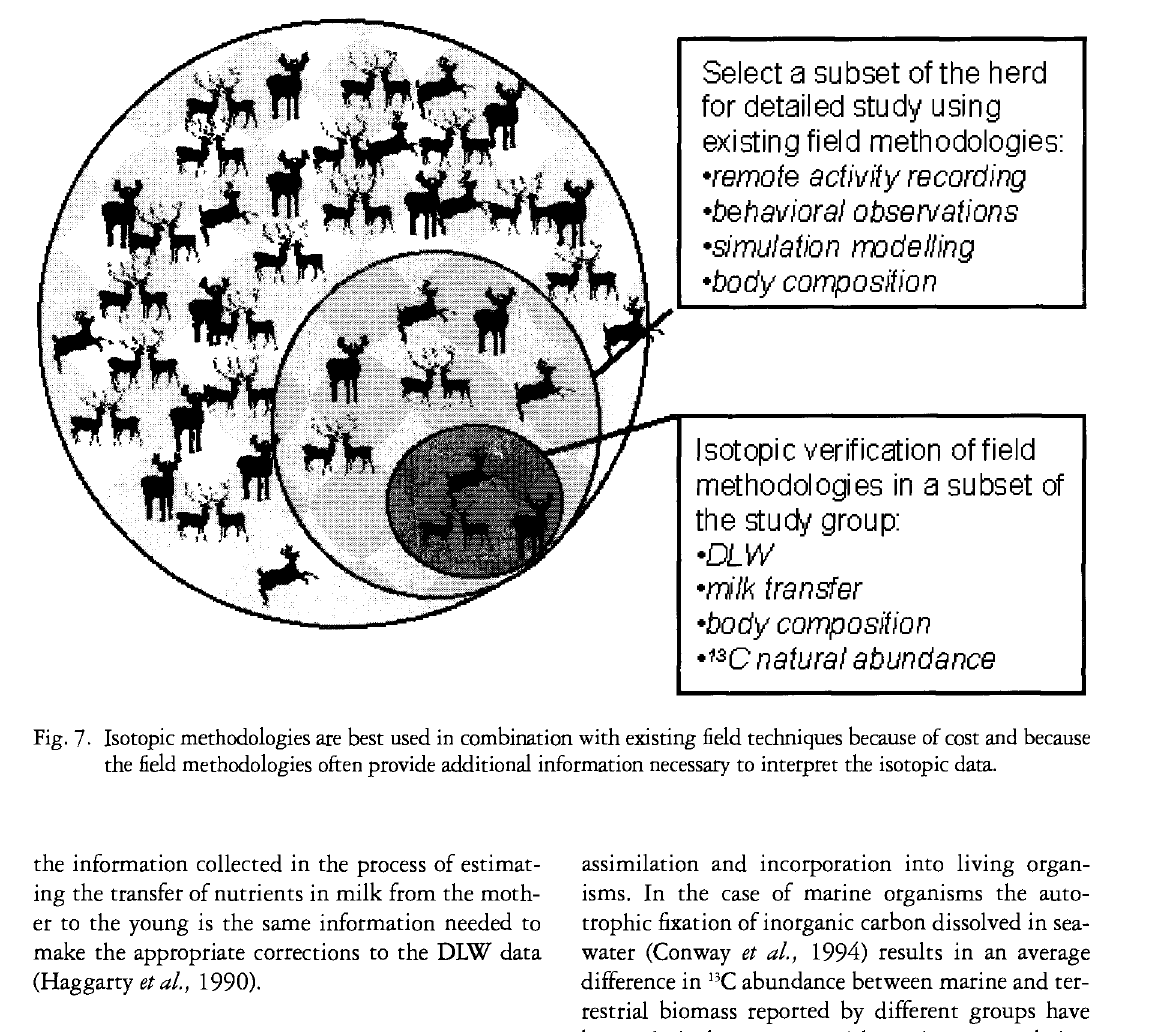
Fig. 7. Isotopic methodologies are best used in combination with existing field techniques because of cost and because the field methodologies often provide additional information necessary to interpret the isotopic data.